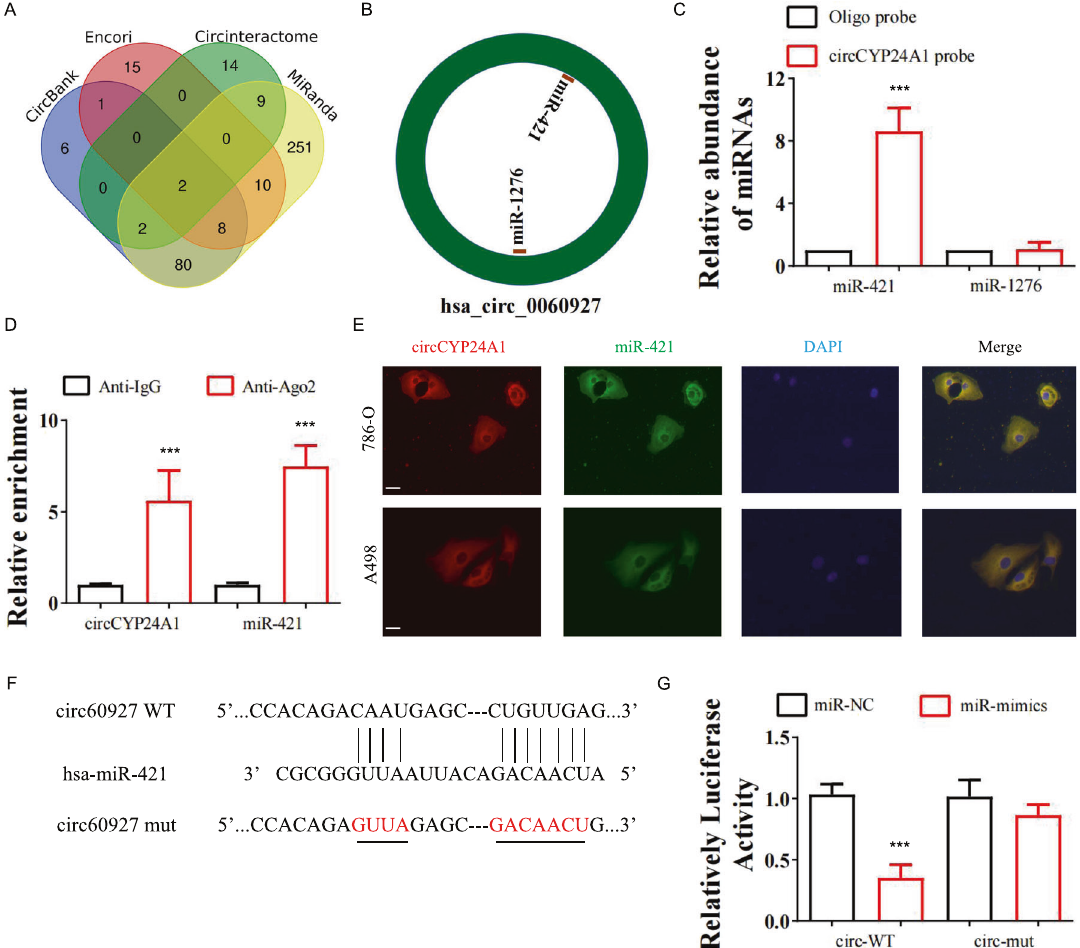
Fig. 3 CircCYP24A1 functions as a sponge for miR-421 in RCC cells. A The miRNAs that potentially interact with circCYP24A1 were screened using four databases: CircBank, Encori, CircInteractome, and MiRanda. B Screening of the four databases identi fi ed miR-421 and miR-1276 as two possible targets of circCYP24A1. C Relative expression of miR-421 and miR-1276 was measured using qRT-PCR after RNA pulldown with the circCYP24A1 probe or the control probe in 786-O cells. D Ago2 RIP was performed to detect the precipitation of circCYP24A1 and miR-421. E CircCYP24A1 and miR-421 were detected by FISH in 786-O and A498 cells. Nuclei were stained with DAPI. The bar corresponds to 20 μ m. F Mutant and wild-type circCYP24A1 sequences were constructed for the dual-luciferase reporter assay. G Relative luciferase activity was measured in 786-O cells transfected with miR-421 mimics or normal control along with mutant or wild-type circCYP24A1. Data are presented as means ± SD. *** p <